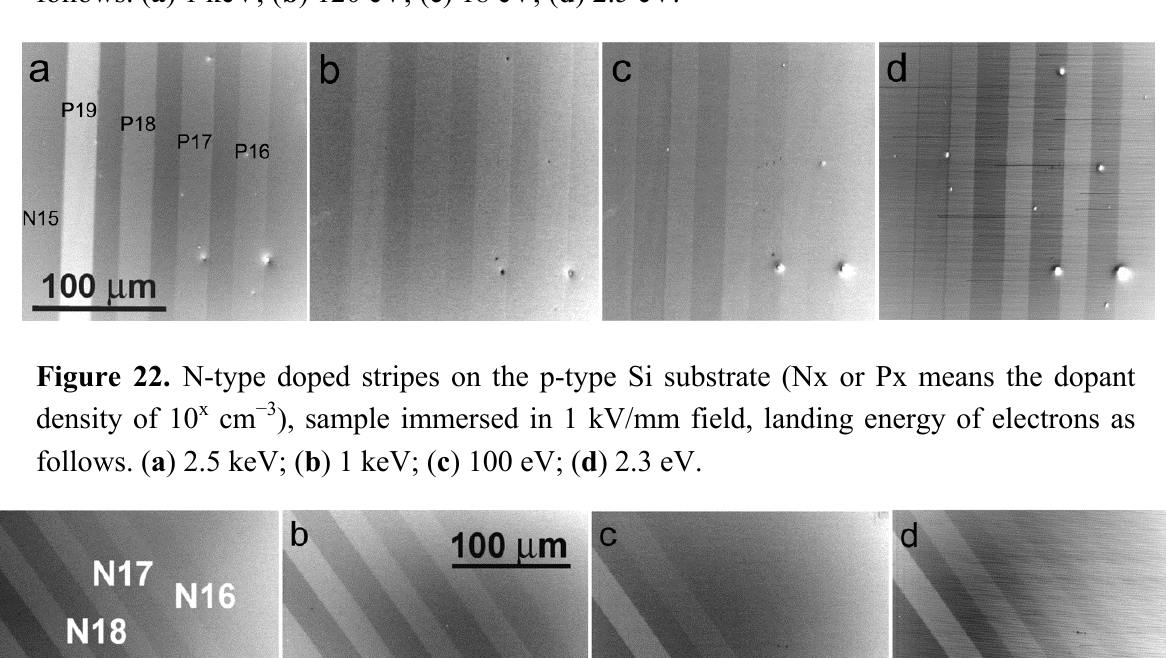
Figure 21. P-type doped stripes on the n-type Si substrate (Px or Nx means the dopant density of 10 x cm − 3 ), sample immersed in 1 kV/mm field, landing energy of electrons as follows. ( a ) 1 keV; ( b ) 120 eV; ( c ) 18 eV; ( d ) 2.5 eV.